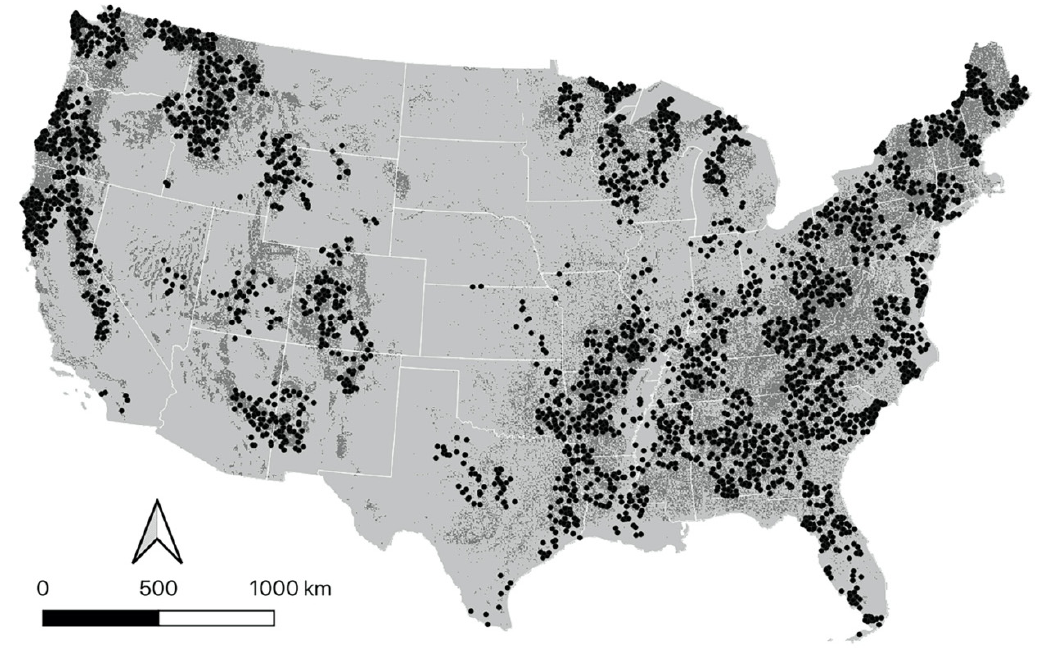
Figure 1. Location of plots used in this study (dots) superimposed on a forest mask (dark gray,